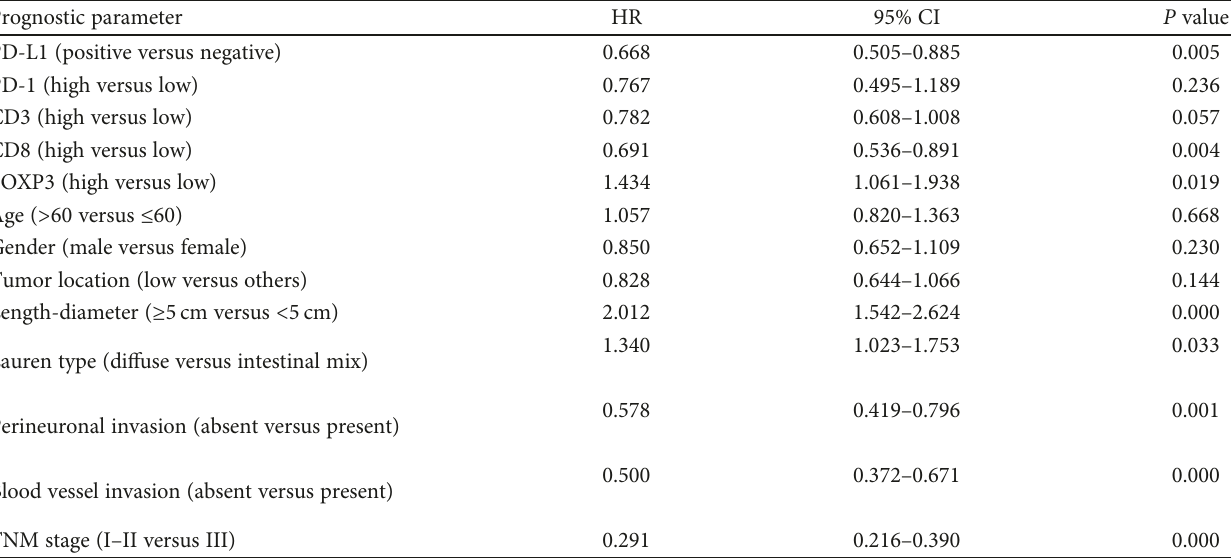
Table 2: Univariate analysis of prognostic parameters for survival in GC